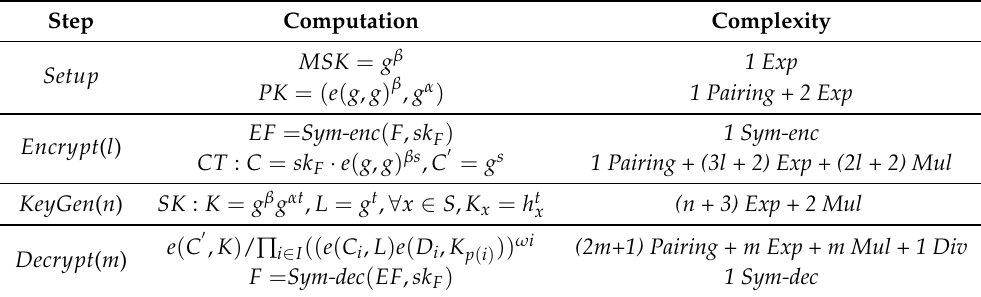
Table 4. Computational